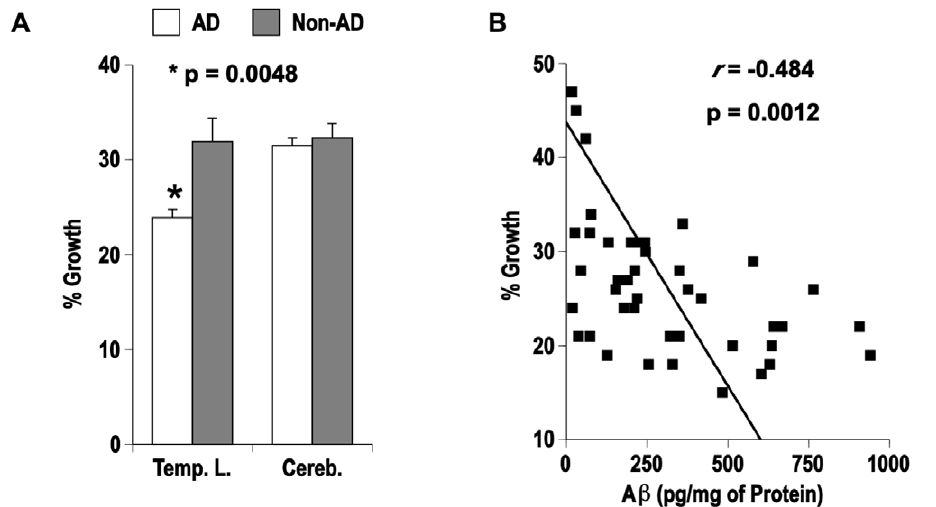
Figure 3. AD brain homogenates have increased antimicrobial activity against C.albicans . AD and non-AD brain samples were tested for A b -mediated inhibition of C. albicans . Samples of temporal lobe ( Temp. L. ) and cerebellum ( Cereb. ) from AD (n=32) and age-matched control subjects (n=13) were homogenized in culture broth. Panel A ; Homogenates were inoculated with log-phase C. albicans and microbial growth determined by alamar blue viability assay. Data is shown as percentage of signal for C. albicans alone (average of four replicates) 6 s.e.m. Panel B ; Homogenates were assayed for A b 40 and A b 42 by commercially available ELISA. Graph shows A b signal (sum of A b 40 and A b 42) against C. albicans growth for temporal lobe homogenates from combined AD and non-demented cohorts (n=42). Probability analysis used unpaired two-tailed t-tests ( p ). Correlation was determined by calculating the Pearson r correlation coefficient ( r ).